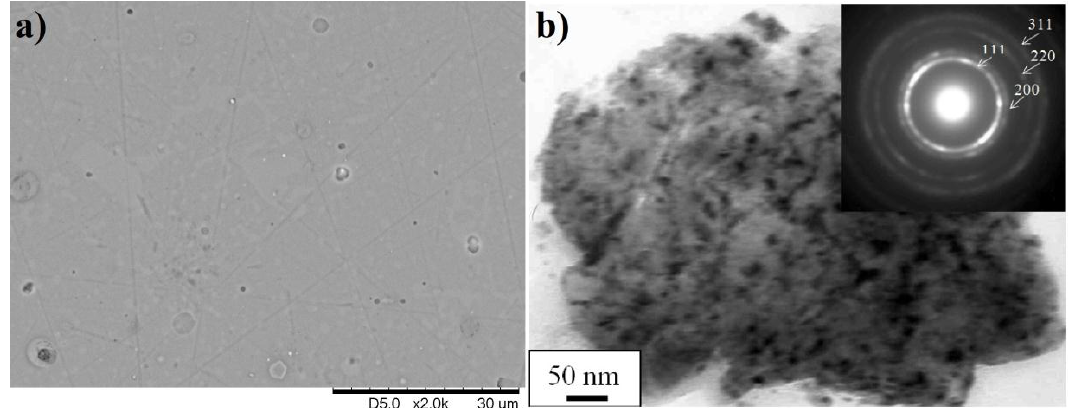
Figure 5. Surface scanning electron microscopy (SEM) image ( a ), and transmission electron microscopy (TEM) micrograph ( b ), of Ti-Al-N coating deposited at 90 A.